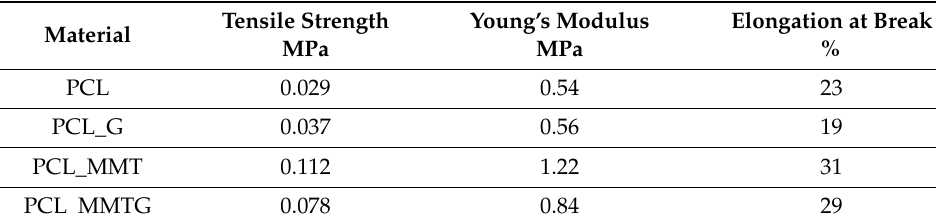
Figure 5. Wettability of nanocomposite fibrous membranes: PCL_MMT, PCL_MMTG and PCL_G vs. wettability of PCL polymer membrane. Table 4. Mechanical properties of nanobiocomposite materials.